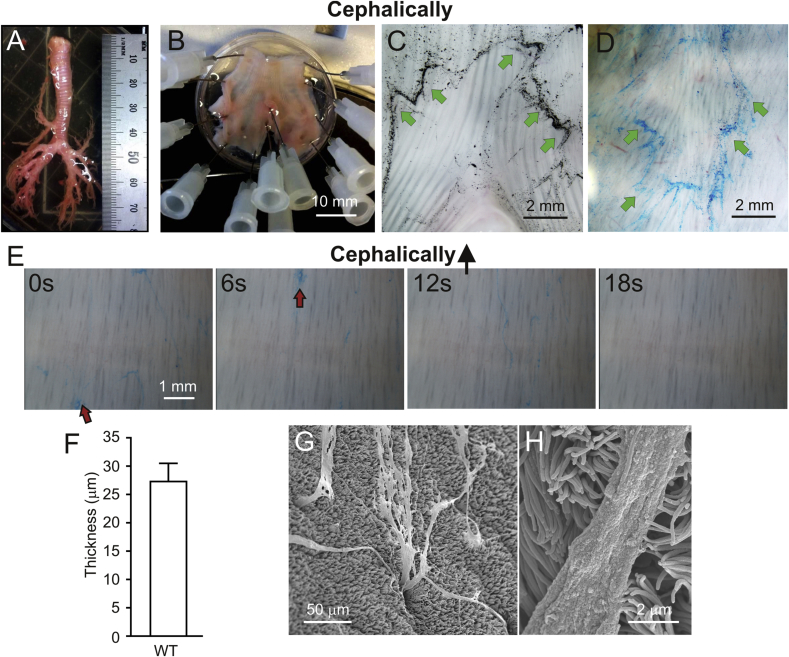
Alcian blue-stained bundles from piglet submucosal glands are transported cephalically. A. Pig trachea. B. Distal trachea and primary bronchi mounted in the experimental chamber. C. Dorsal side of piglet trachea with bifurcation and charcoal collected in the mucus. Mucus was moved cephalically and outwards as indicated by the green arrows. D. The ventral side of the trachea with Alcian blue-stained bundles moving according to the arrows, up and ventrally. E. Pig trachea mounted as in B with Alcian blue-stained bundles moving upwards over the surface in Movie S1. Images at 0, 6, 12 and 18 s from the same surface of a time-lapse recording at 16 times the original speed. Red arrows point to the same mucus bundles. F. Diameter of Alcian blue-stained bundles in airways, mean of 8 bundles from 3 pigs. G. SEM image of a pig trachea with bundles coming out of submucosal glands. H. Mucus bundle and cilia appear to interact.